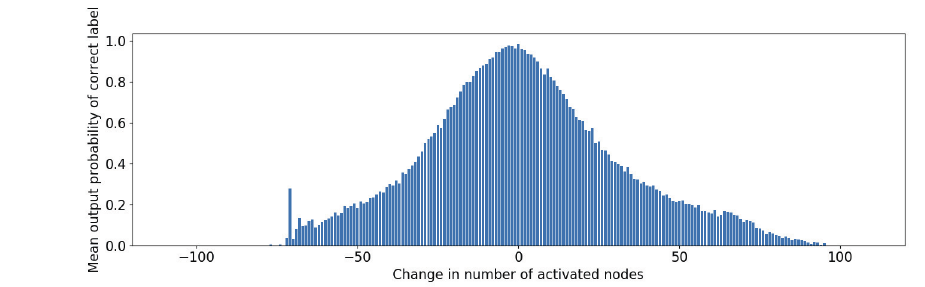
Figure 4: Simulation of relationship between the change in the number of all layers’ activated nodes and the mean output probability of the correct label in the MLP model with